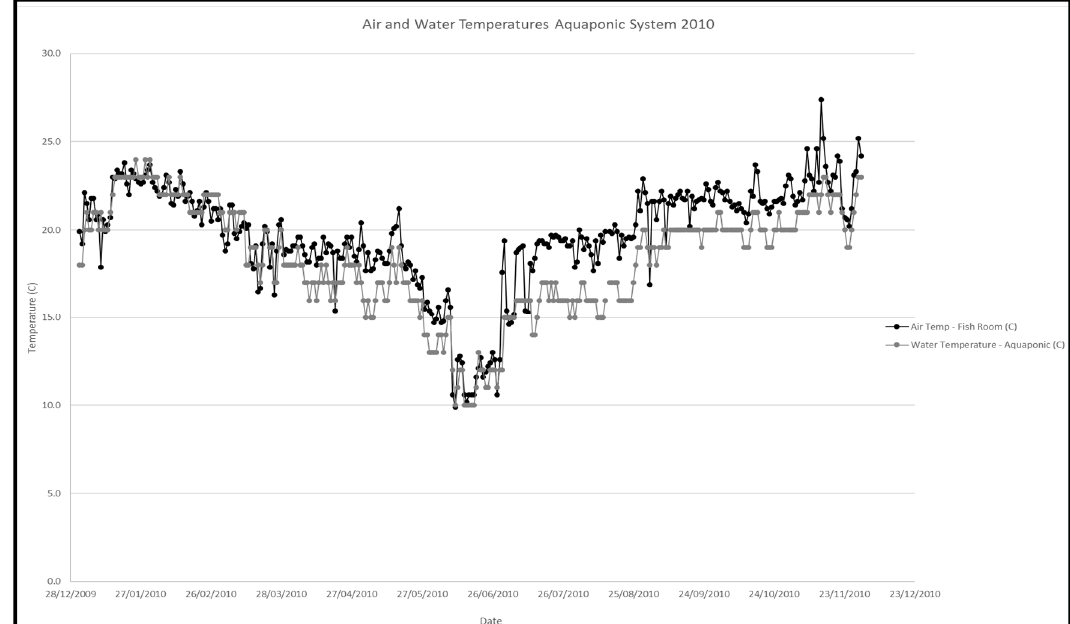
Figure 2. Air (fish room) and water temperatures for the aquaponic system across the trial period.